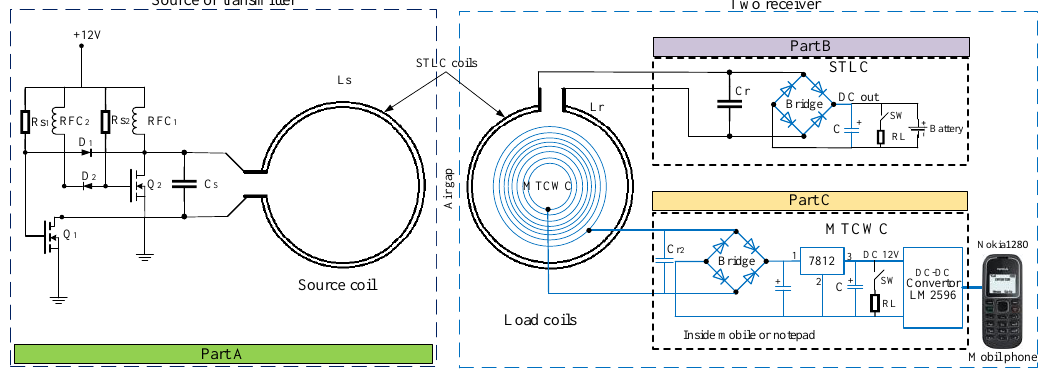
Figure 1. Proposed Single-tube loop coil (STLC) and multi-turn copper wire coil (MTCWC) systems.